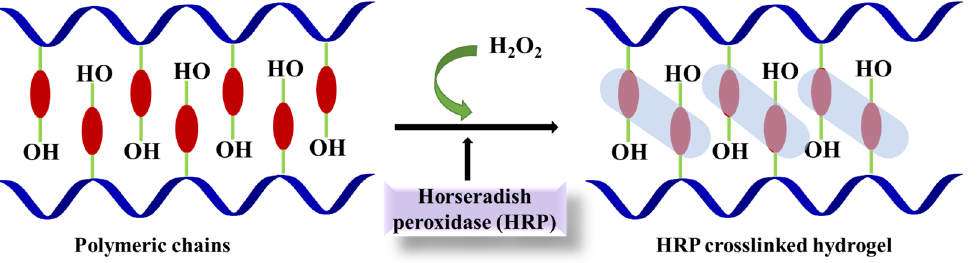
Figure 6. Mechanism of crosslinking via horseradish peroxidase for hydrogel formation.